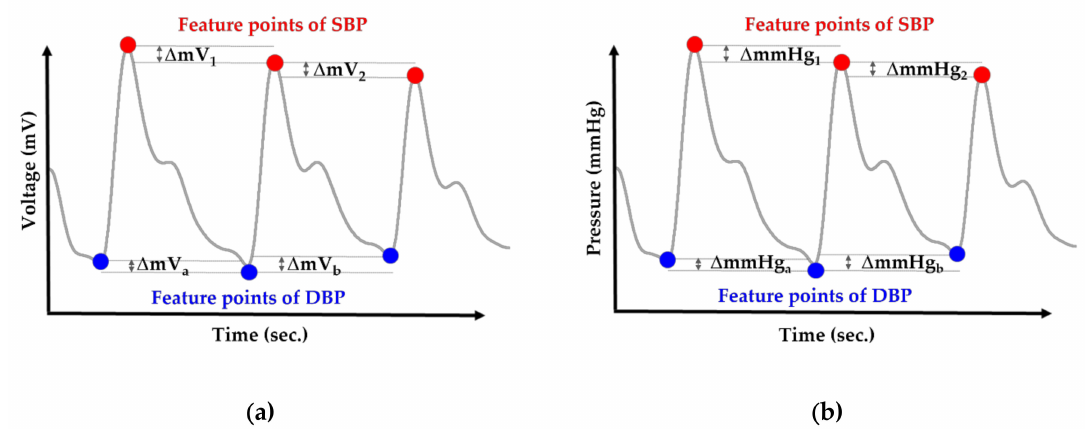
Figure 1. ( a ) Calculate the ∆ mV at the systolic blood pressure (SBP) and diastolic blood pressure (DBP) feature points within the adjacent wave. ( b ) Convert the voltage change ( ∆ mV) into pressure change